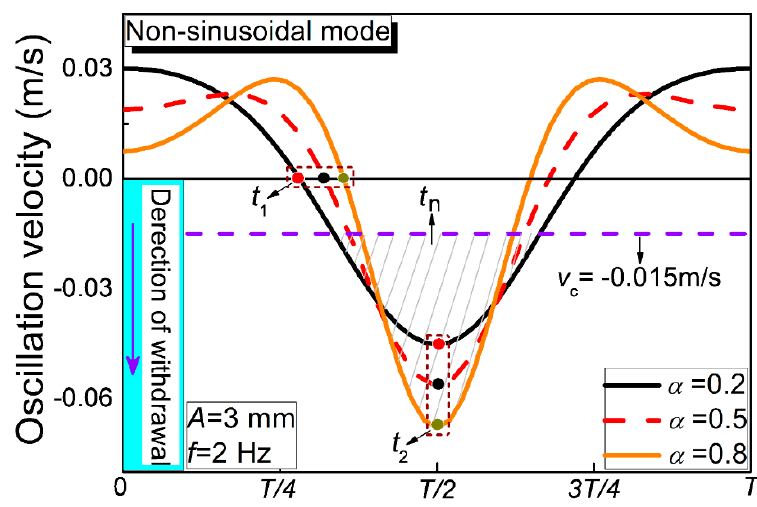
Figure 3. Oscillation velocity of nonsinusoidal mode with different modification ratios.